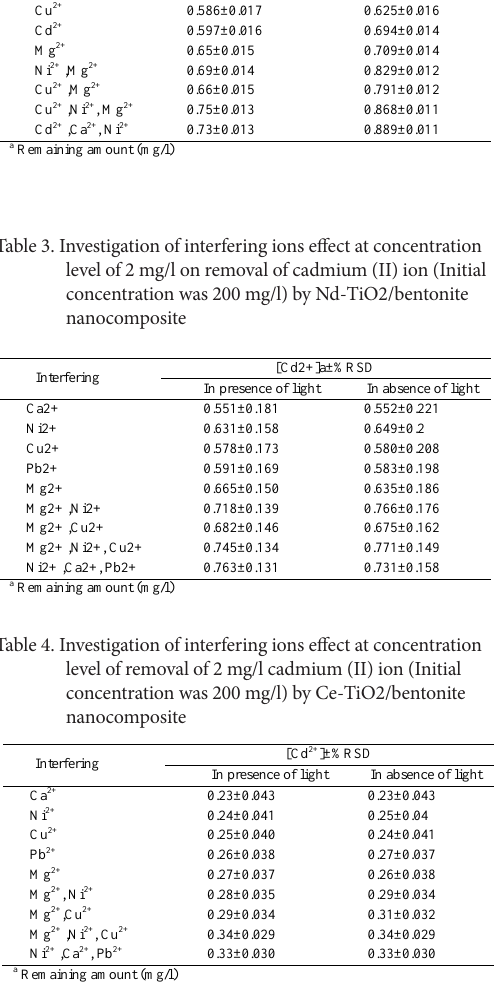
Table 6. Langmuir and Freundlich isotherm constants for the adsorption of lead (II) and cadmium (II) ion by Nd-TiO 2 / bentonite nanocomposite Ion